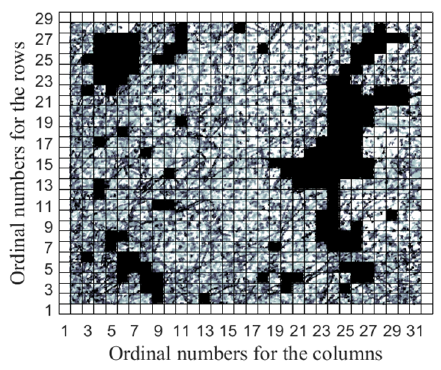
Figure 18. The gray level map for the flatness of the safe zone. Twenty elevation points were randomly selected in the safe zone, and their x and y coordinate values were encoded to get the initial particle swarm. According to task requirements, the particle fitness threshold was set as G best = 0.95 and the speed variation range was set as [ − 2, 2 ] ms − 1 . Based on the PSO, the detecting point was selected after nine iterations (the maximal number of iterations was set as K max = 50), which lasted 12.343 s. The iterative search processes of detecting points are shown in Figure 19a, and the corresponding particle positions and the fitness changing process are shown in Table 2.